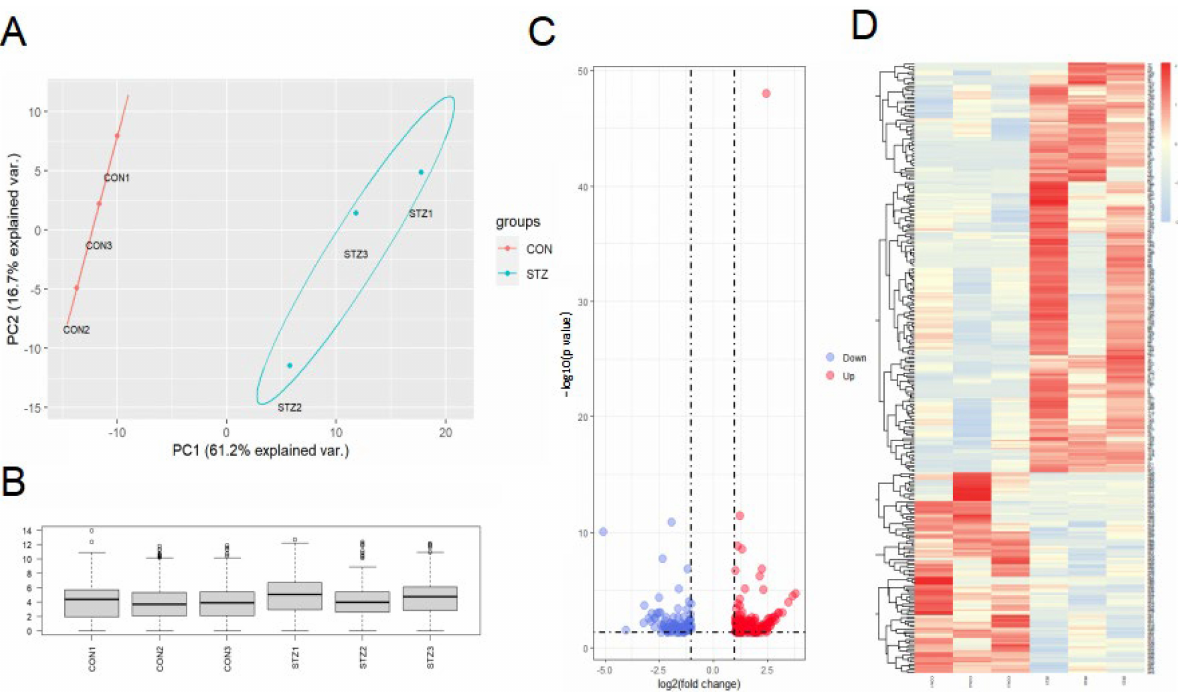
Figure 2. Identification of DEGs in the RNA sequencing of early DR mice models. ( A ). PCA blot for the repeatability of RNA sequencing. ( B ). Boxplot for the quality of RNA sequencing. ( C ) Volcano plot of the expression of DEGs; red nodes represent up-regulating genes while blue nodes represent down- regulating ones. ( D ). Heatmap of the expression of DEGs, red color represents higher expression while blue color represents lower